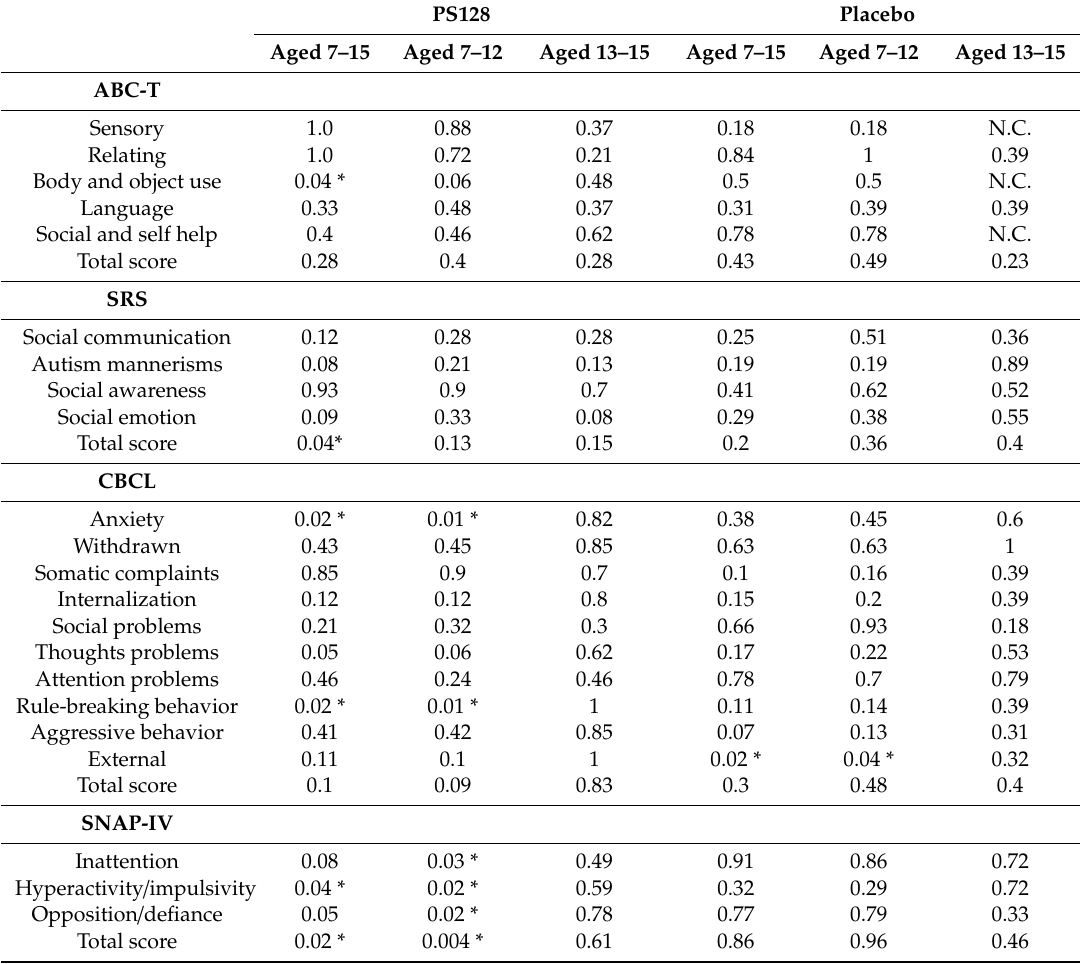
Table 3. Analysis of di ff erence between baseline and week 4 of PS128 and placebo